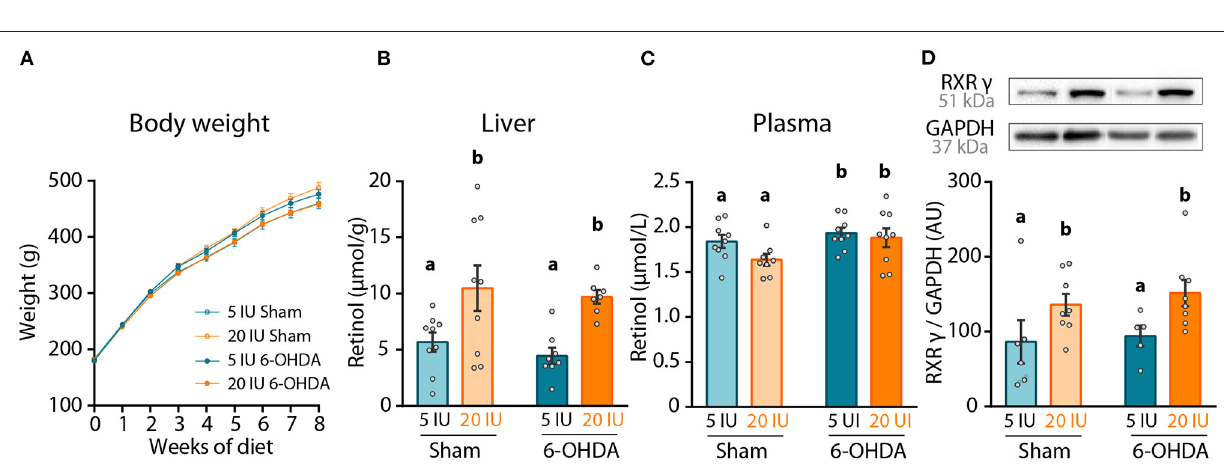
additional weeks during which, behavioral tests were